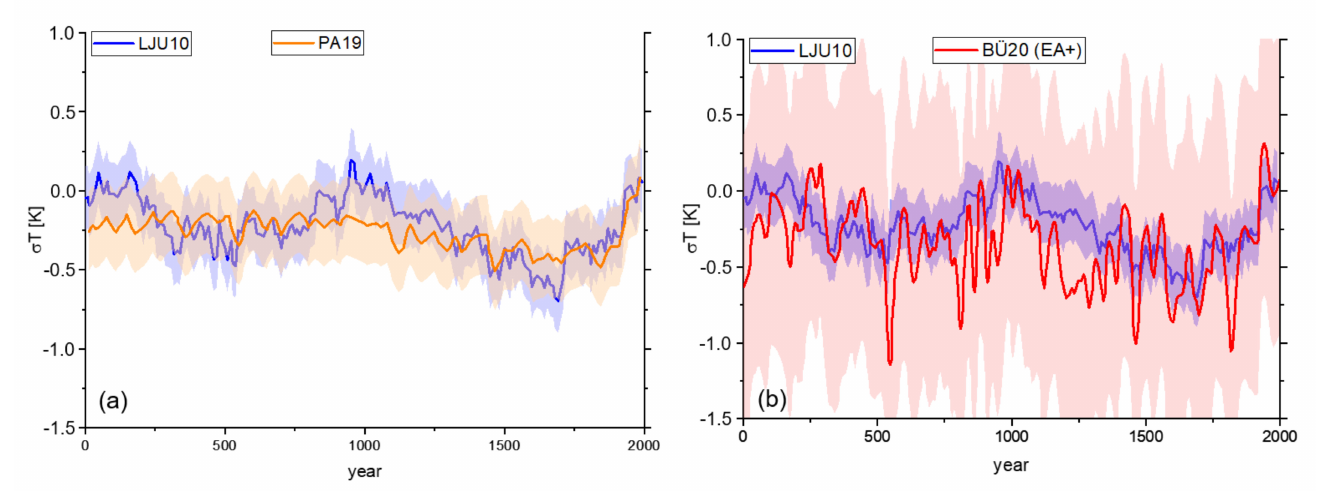
Figure 2. Comparison of reconstruction LJU10 vs. PA19 ( a ), and LJU10 vs. BÜ20 ( b ), including error bars. The temperature measurements contained in the original manuscript are not